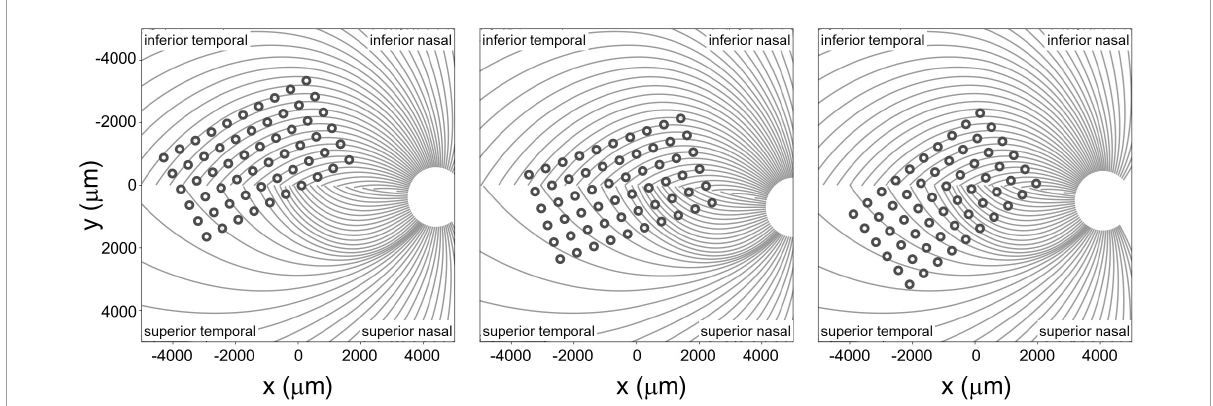
FIGURE4 Estimated position of the electrode array on the retinal surface for all three participants (see Beyeler et al., 2019 for estimation methods) overlaid on estimates of the axon fiber pathways for that participant. Note that all panels are in visual space coordinates, with the upper visual field at the top of the